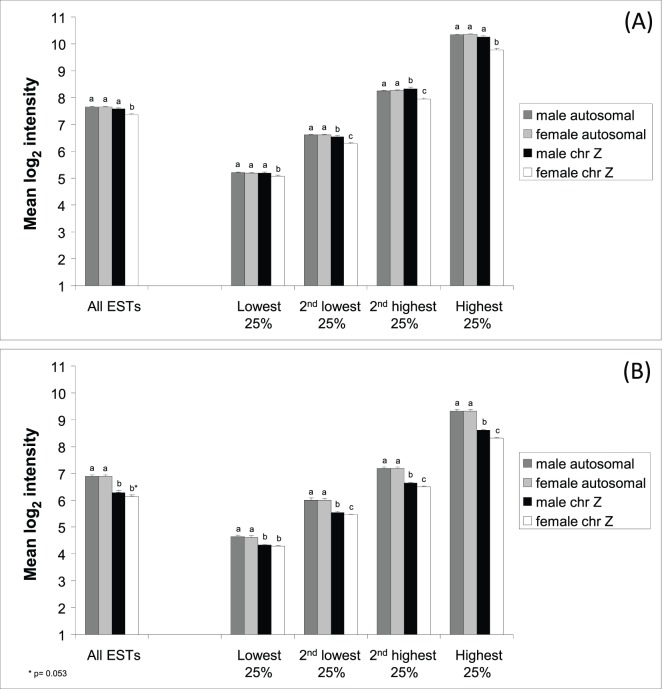
Mean (±SE) gene expression intensity of autosomal and Z-linked ESTs in (A) zebra finch and (B) common whitethroat.Data for all ESTs and when divided into quartiles by mean gene expression intensity from lowest 25% to highest 25% are given. Significant differences (p<0.05) between categories are indicated (a, b and c).